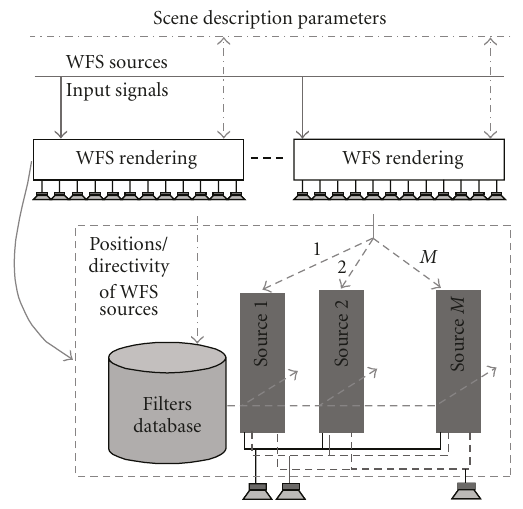
Figure 20: WFS system rendering architecture.